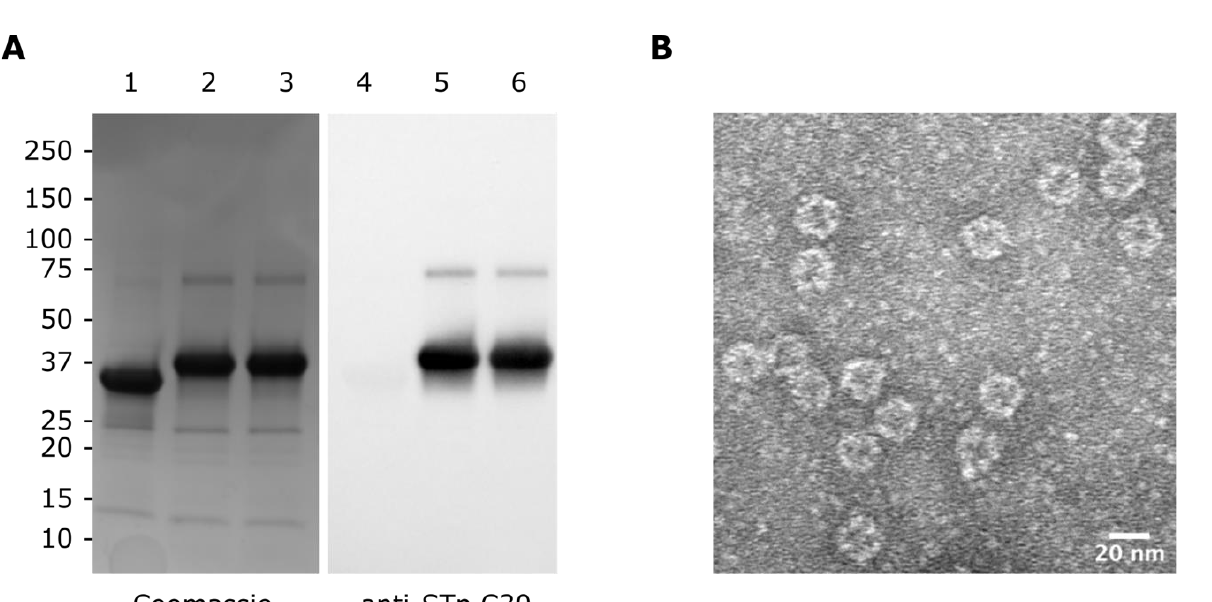
Figure 2. Characterization of STh mutant mi3-nanoparticles. ( A ) Coomassie stained SDS-PAGE (left) and immunoblot (right) of unconjugated mi3-SpyC (lanes 1 and 4) and the mi3-SpyC:SpyT-STh-A14T (lanes 2 and 5) and mi3-SpyC:SpyT-STh-L9A/A14T (lanes 3 and 6) immunogens. Anti-STp mAb C30 was used as primary antibody in the immunoblot. Molecular masses (kDa) of the protein standard are shown to the left. ( B ) Negatively stained transmission electron micrograph of mi3-SpyC:SpyT-STh-L9A/A14T with scale bar (bottom right).